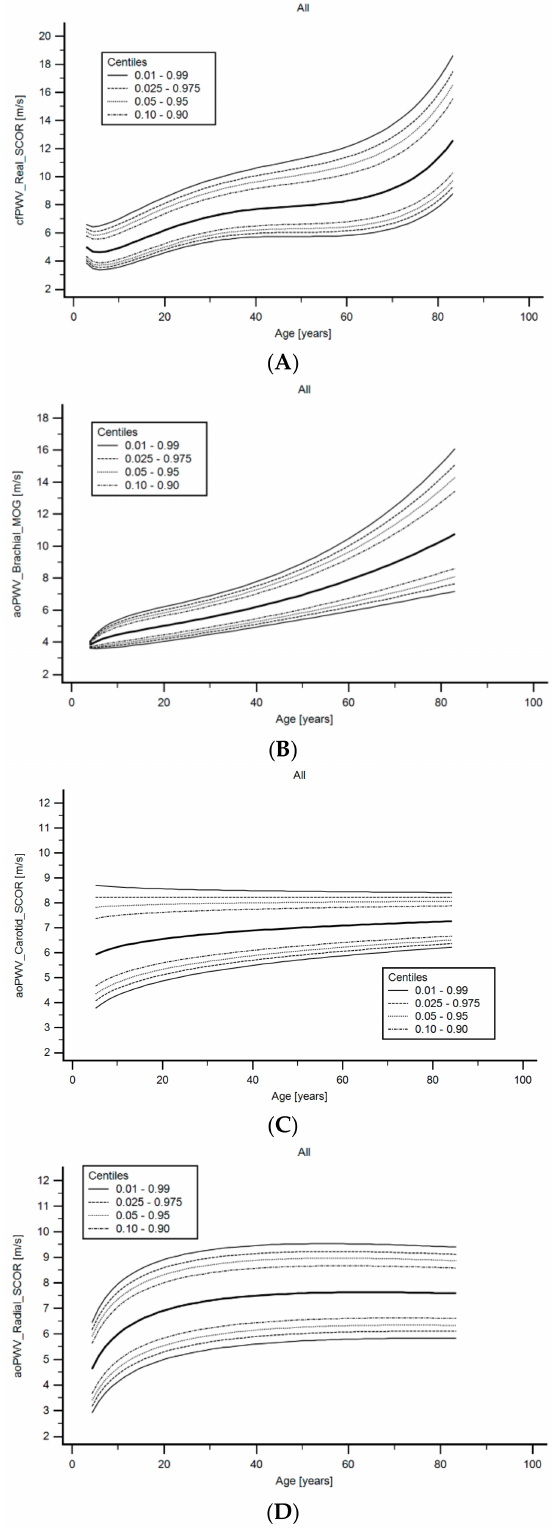
Figure 9. cfPWV_Real_SCOR ( A ), aoPWV_Brachial_MOG ( B ), aoPWV_Carotid_SCOR ( C ) and aoPWV_Radial_SCOR ( D ) age-related profiles for subjects included in the RI